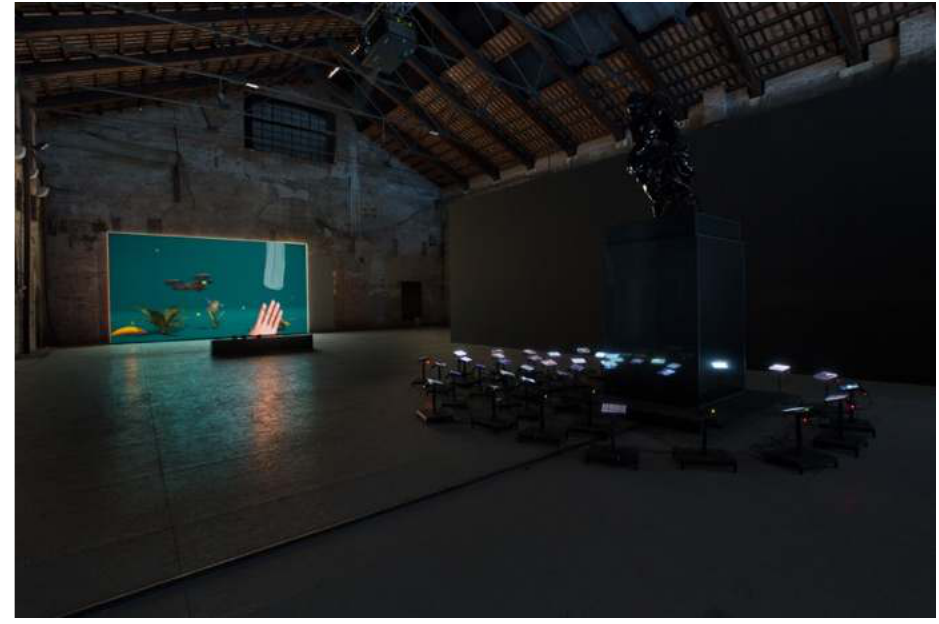
Photo by Vinciane